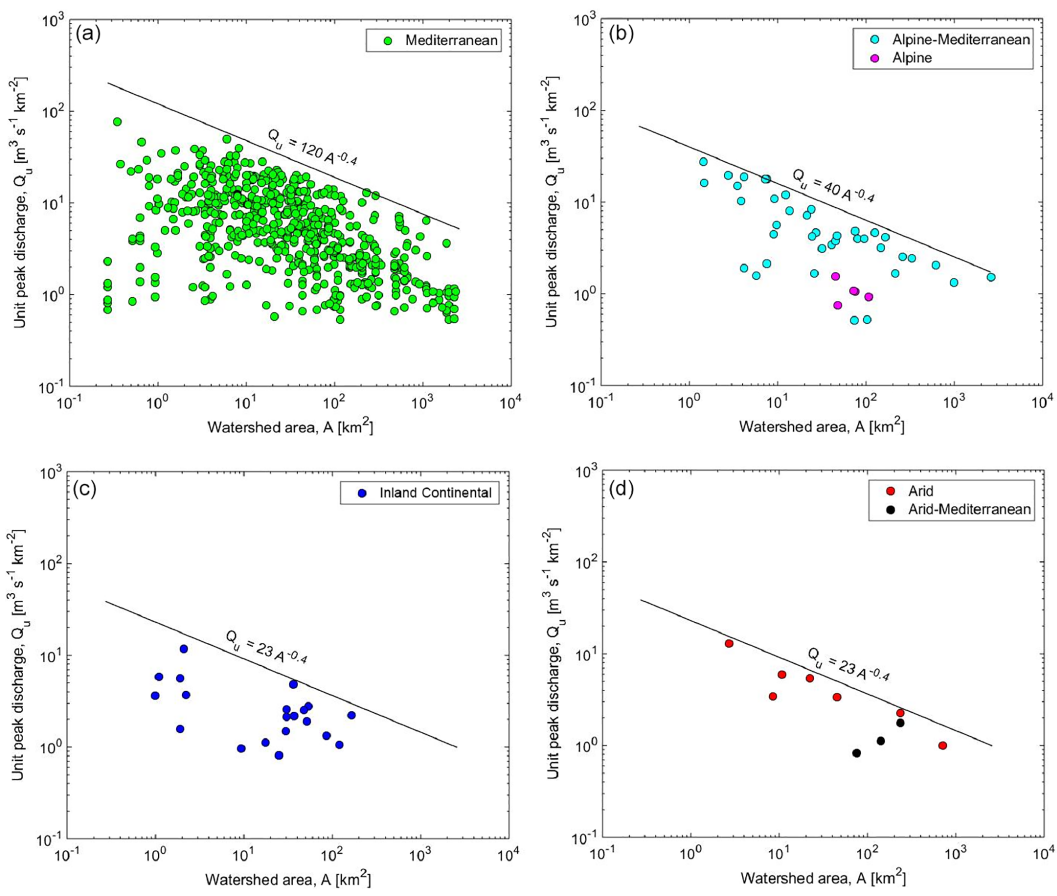
Figure 4. Unit peak discharges versus drainage areas based on climatic regions: (a) Mediterranean catchments, (b) Alpine-Mediterranean and Alpine catchments, (c) Inland Continental, and (d) Arid and Arid-Mediterranean catchments. The envelope curve for each climatic region is reported.